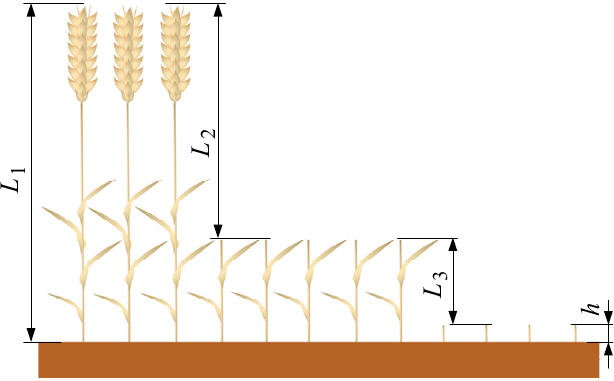
Figure 2. Operation diagram of the DCH.